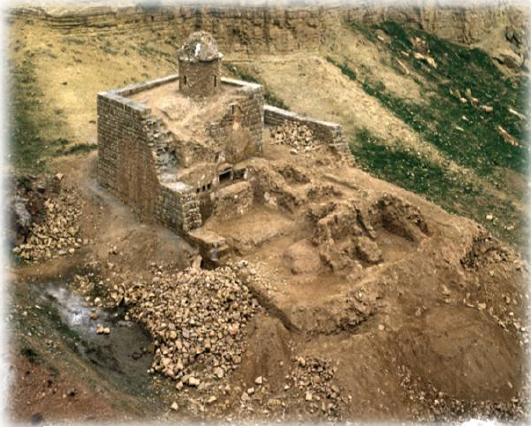
Figure 6. Ramparts of Chupan church.befor restoration of 2014